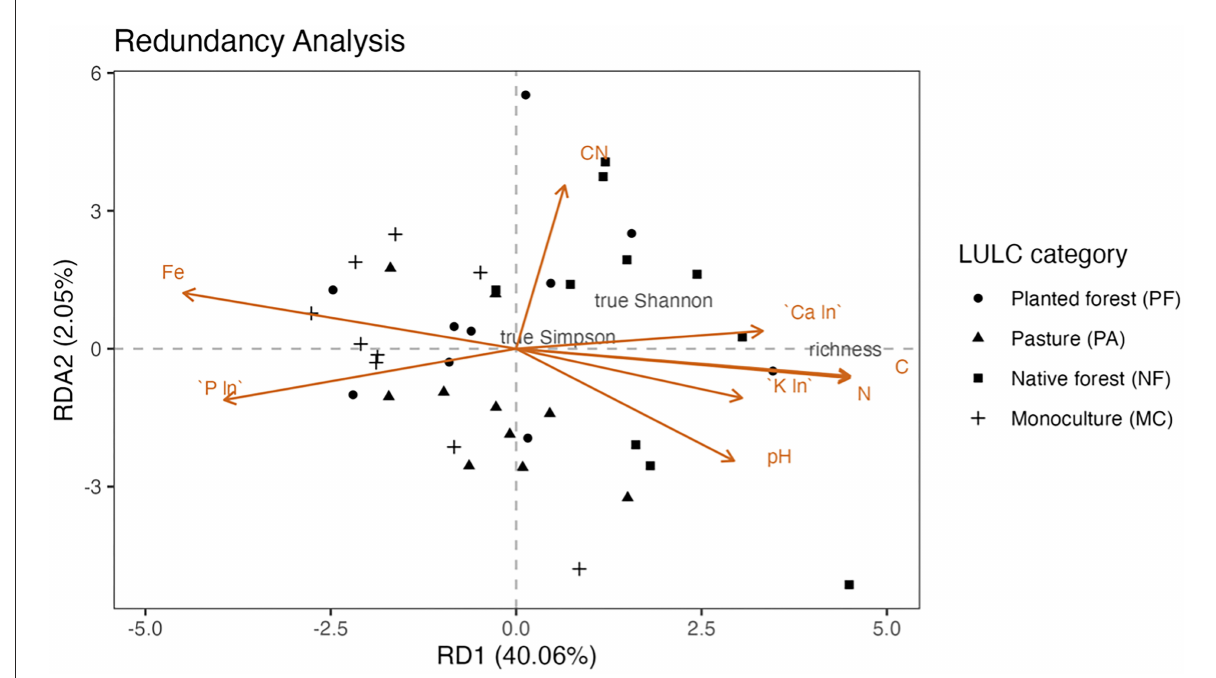
FIGURE8 Redundancy analysis of the soil chemical parameters and diversity of edaphic macroinvertebrate community. Significant parameters: **Org carbon, *pH. Asterisks illustrate the power of the levels of significance of the statistical test: * p ≤ 0.05; ** p ≤ 0.01.